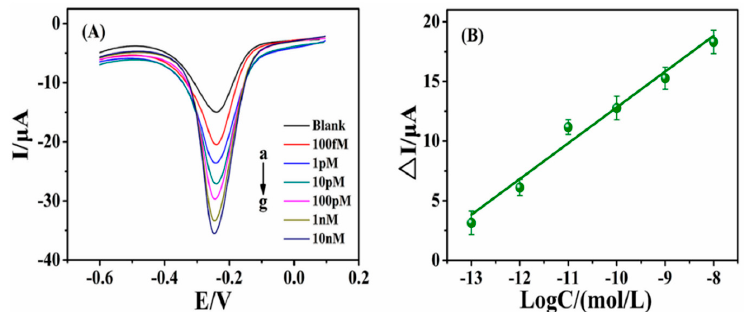
Figure 3. ( A ) DPV curves corresponding to the different detection concentrations of target DNA: 0, 100 fM, 1 pM, 10 pM, 100 pM, 1 nM, 10 nM, respectively; ( B ) Linear relationship of the reduction peak current with the target DNA concentration.